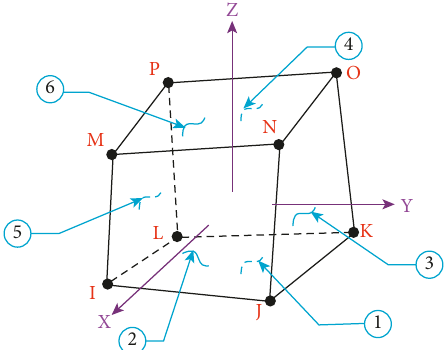
Figure 5: SOLID185 3D element [39, 44]. Table 5: Material properties used for FE of steel plates. Material model number